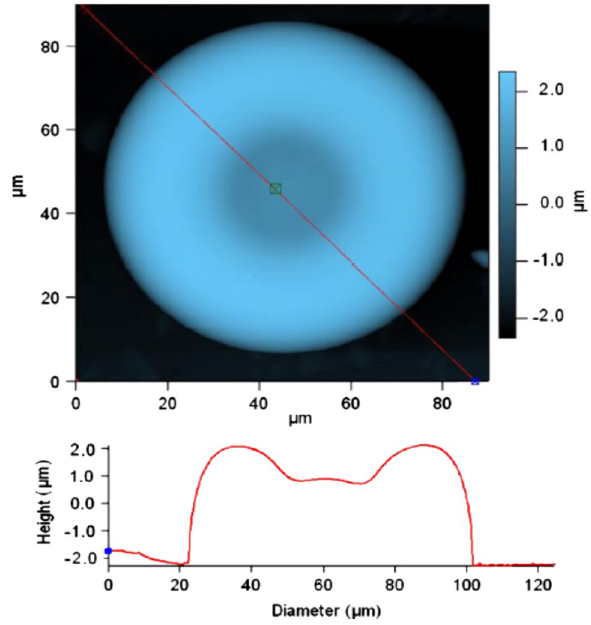
Fig. 15 Characterization of the starting powder with a XRD and b FTIR [92] Fig. 16 FIB image of solidified CaP droplet splats